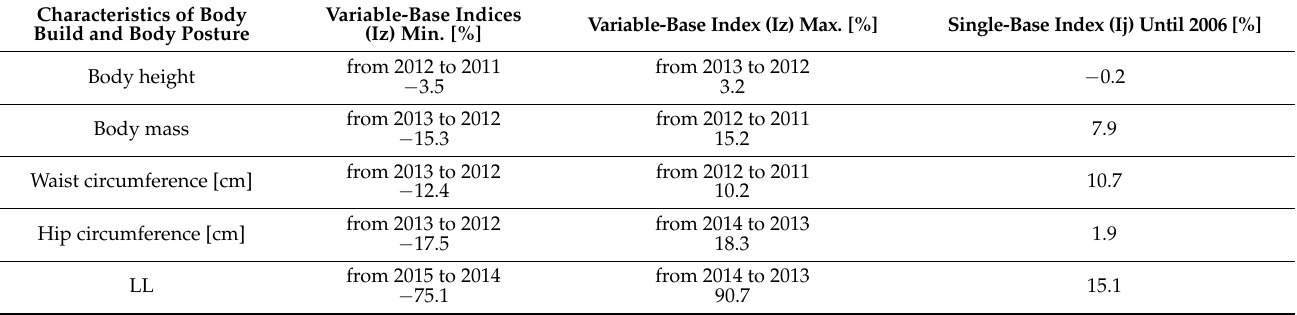
Table 6. Dynamics of variability of time series for the characteristics of body build and posture in women [%] in terms of single-base indices (Ij) and variable-base indices (Iz) between 2006 and 2016. Characteristics of Body Build and Body Posture